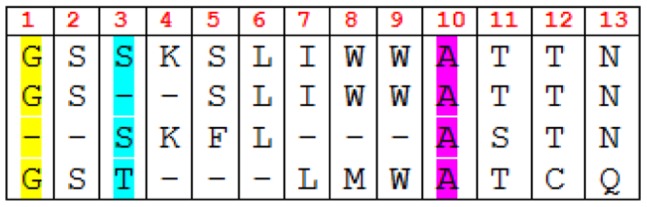
A result set to explain entropy based diversity on amino acid level.